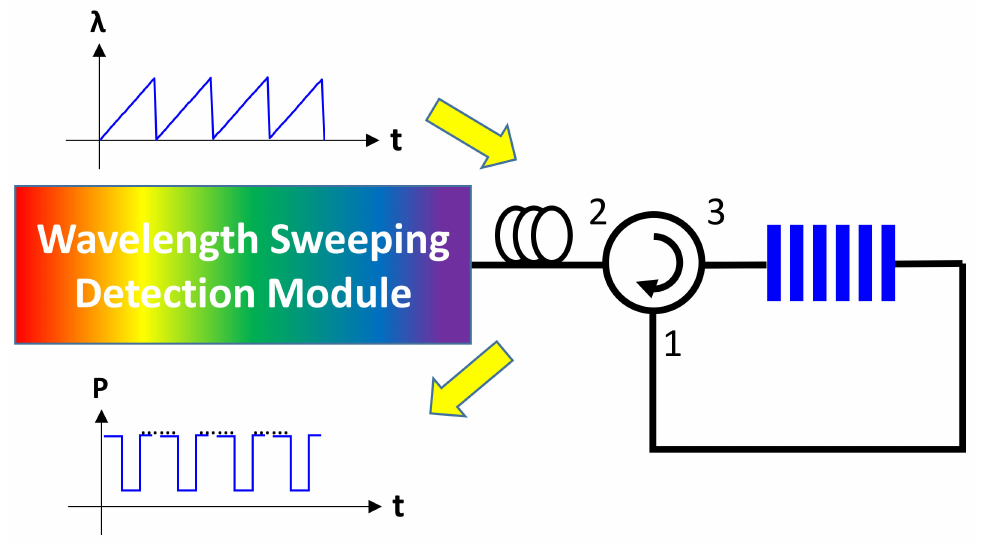
Figure 8. Experiment